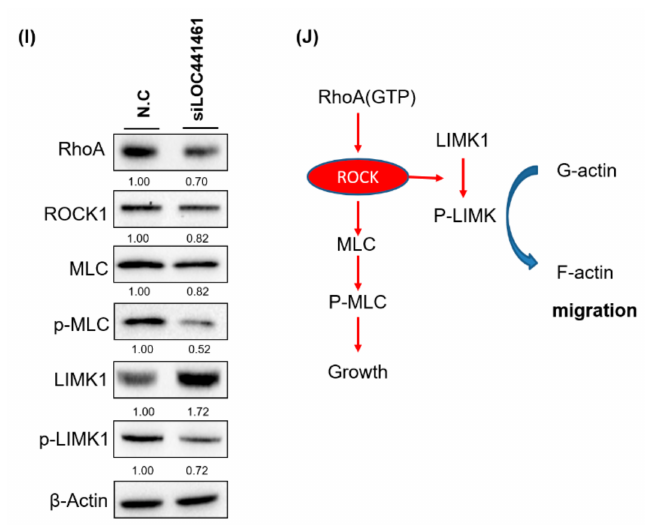
Figure 5. LOC441461 knockdown suppressed colon cancer cell motility. ( A , B ) Four colon cancer cell lines, DLD-1, LoVo, LS174T, and HT29, were seeded in the upper chamber of transwells with or without a coating of Matrigel (invasion and migration assay, respectively). After incubation for 12 h, the invading and migrating cells were counted. ( C , D ) The invasion and migration abilities were quantified using the Ascent software. ( E ) LOC441461 knockdown suppressed DLD-1 cell invasion and migration. ( F ) The invasion and migration abilities were further quantified using Ascent software. The migration and invasion experiments were performed in triplicate, and these data were analyzed using Student’s t test. The di ff erence was considered significant when p < 0.05. ( G ) The expression levels of epithelial–mesenchymal transition markers were examined in the DLD-1 cell line with LOC441461 knockdown by using the Western blotting assay. ( H ) LOC441461 expression levels in the primary tumor, metastatic liver tumor, and corresponding normal mucosa of 35 patients with CRC were examined. LOC441461 expression levels in the CRC, adjacent normal mucosa, and liver metastases were analyzed using Student’s t test. ( I ) RhoA, ROCK, MLC, pMLC, LIMK1, and pLIMK1 protein levels in the DLD-1 cells with LOC441461 knockdown were examined using Western blotting. ( J ) Hypothetical